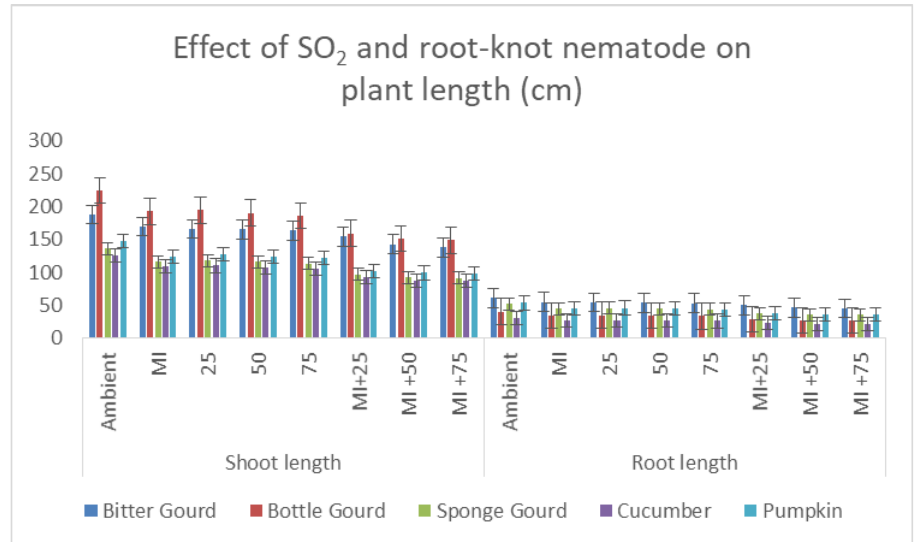
Figure 7. Bar diagram showing the effect of SO 2 exposure and root-knot nematode on the plant length of five cucurbits. Table 2. Effect of intermittent exposures of SO 2 (ambient, 25, 50, and 75 ppb) and root-knot disease ( M. incognita ) on plant biomass production in terms of dry weight of the five cucurbits.